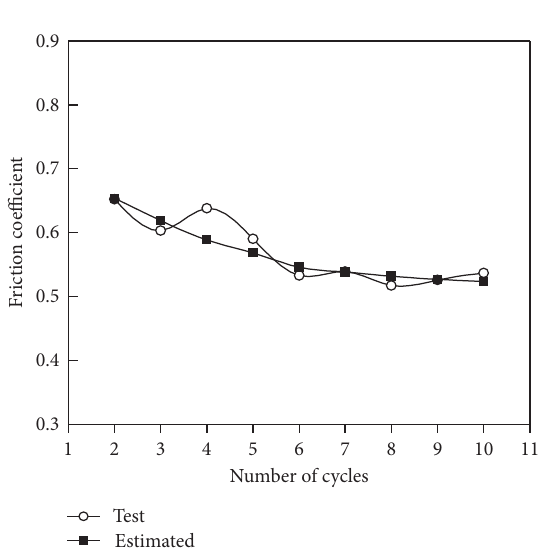
Figure 12: Variation of friction coefficient with